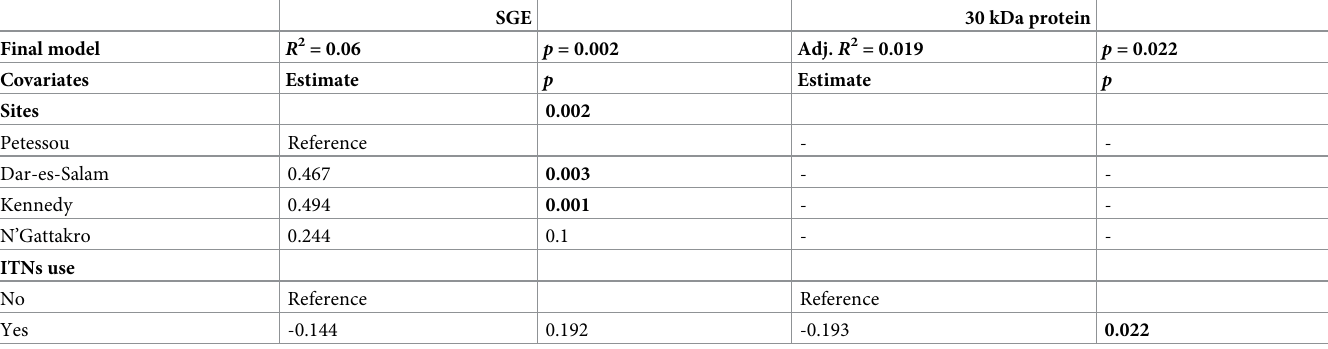
Table 3. Multivariate analysis of specific IgG levels to SGE and to the 30 kDa in children.